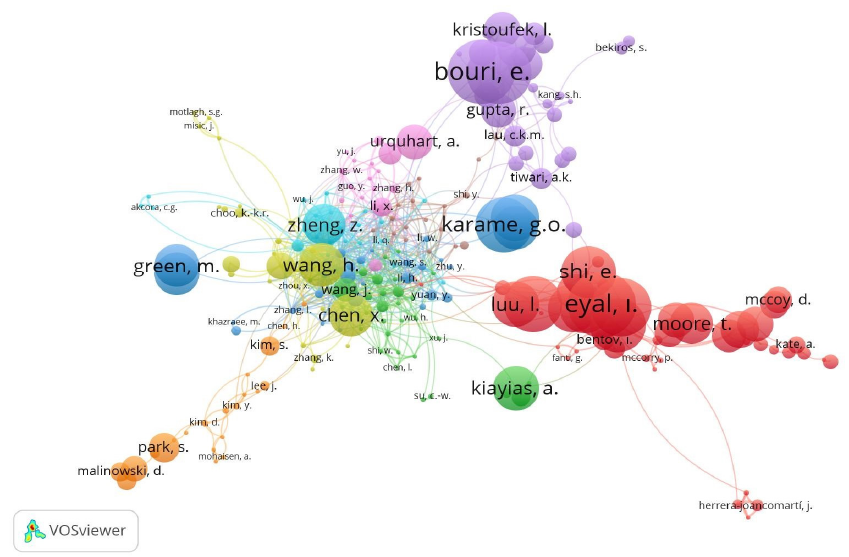
Figure 4. Author network analysis.